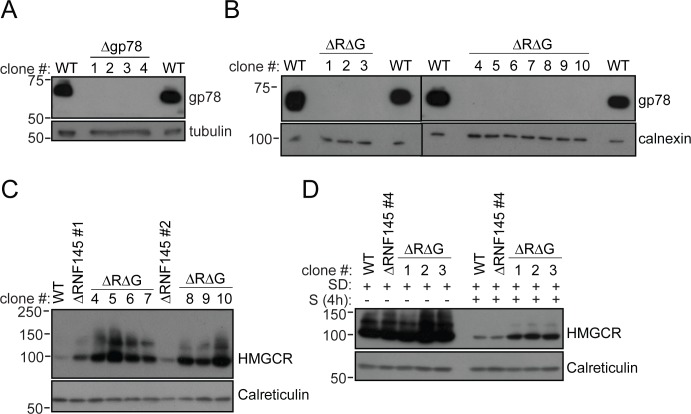
RNF145/gp78 double-knockout cells show increased HMGCR at steady-state and impaired sterol-induced HMGCR degradation.(A) Immunoblot of four HeLa gp78 knockout clones derived by transfection with two independent gp78 sgRNAs. (B) Confirmation of gp78 loss in RNF145/gp78 knockout HeLa cells (ΔRΔG) derived from ∆RNF145 clones #1, #2, and #4 (for validation of RNF145 knockout see Figure 3—figure supplement 1). Calnexin serves as a loading control. (C) Steady-state expression of HMGCR in HeLa WT, ΔRNF145, and RNF145/gp78 double knockout clones (ΔRΔG) was determined by immunoblotting. (D) Indicated cell lines were sterol-depleted (SD) overnight ± sterols (S, 4 hr) and HMGCR detected by immunoblotting. Calreticulin serves as a loading control.